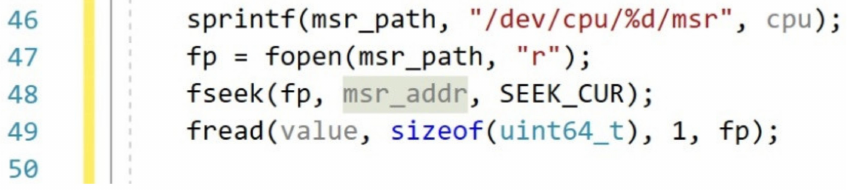
Figure 9. Pseudo-code of MSR